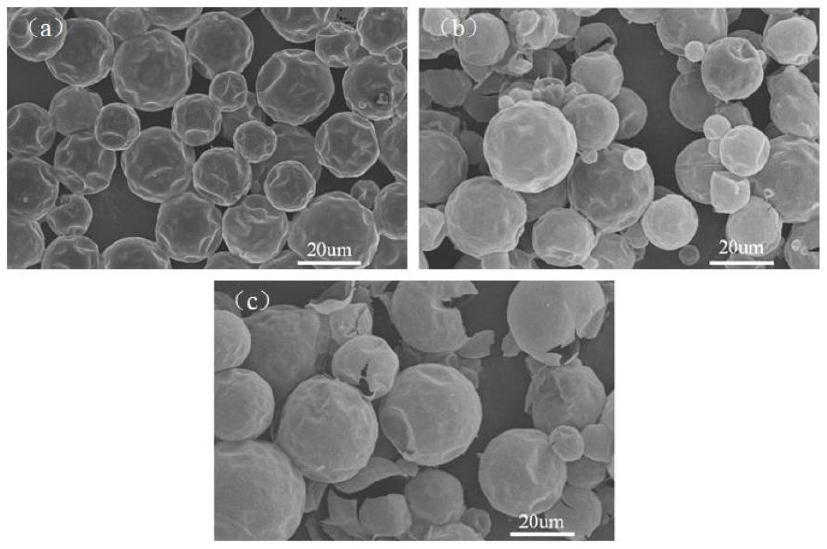
Figure 1. Effects of various core/shell ratios on morphology of polyurethane MicroPCMs: ( a ) 1:1; ( b ) 2:1; and ( c ) 3:1.